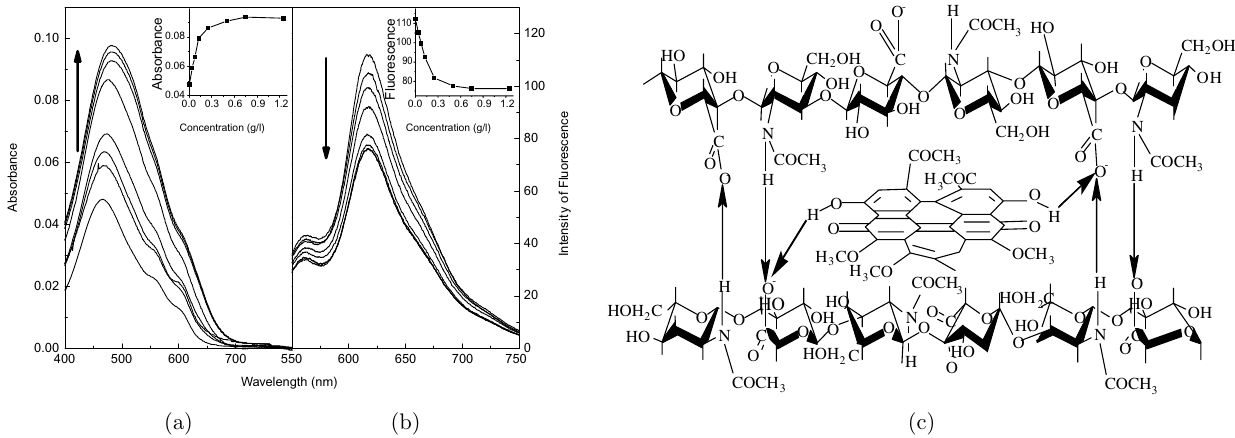
Fig. 8. Absorption (a) and °uorescence spectra (b) of HB (8 (cid:1) M) in PBS (pH 7.0) in the presence of HYA with a series of concentrations. Insets: The plots of the absorbance and °uorescence intensities to the concentrations of HYA. (c) The structure model of HB binding to two HYA.